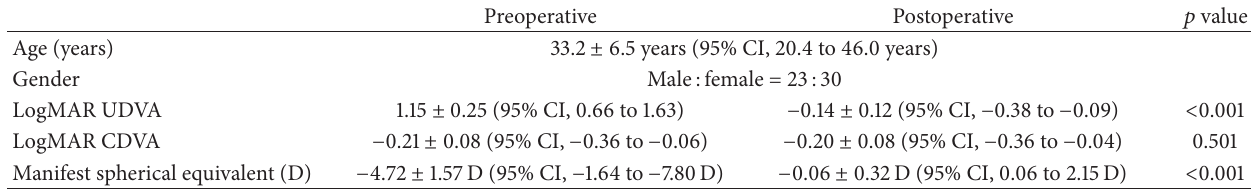
Table 1: Preoperative and postoperative demographics of the study population.